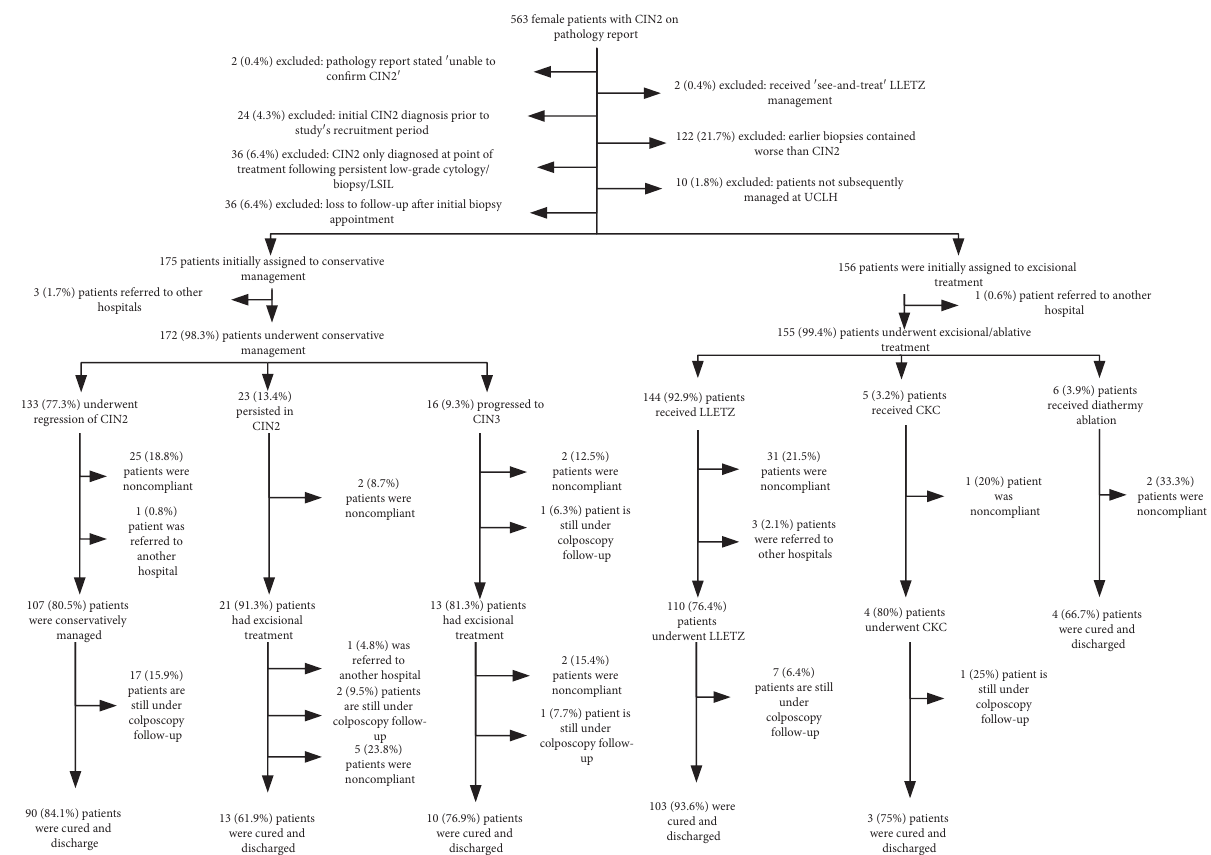
Figure 1: Patient recruitment